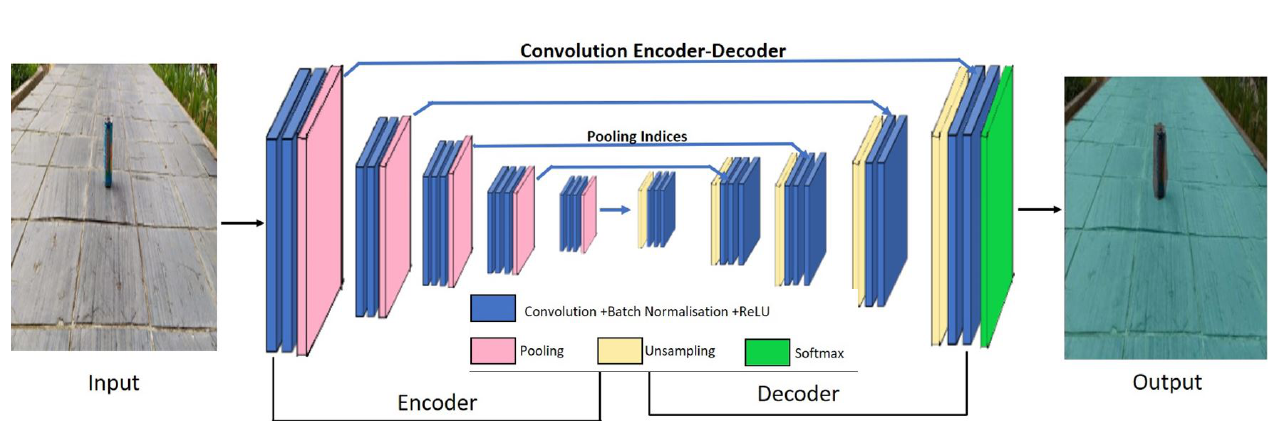
Figure 6. SegNet block